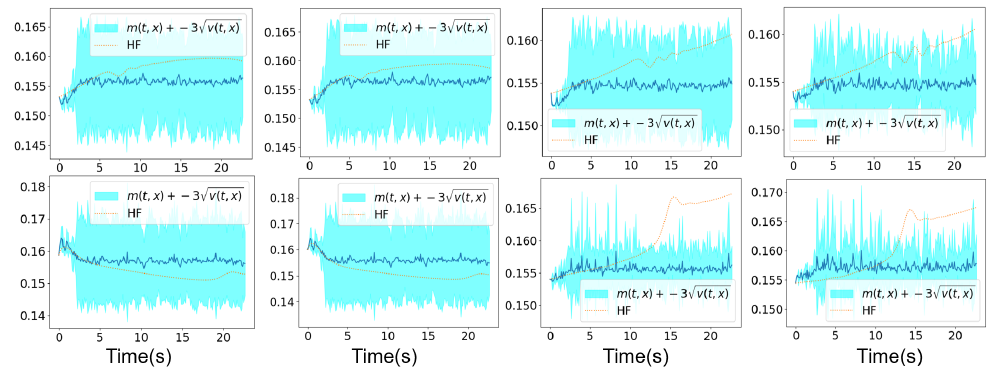
Figure 17. Mesh n°3: High-fidelity Yales2 horizontal velocity projected on the Cartesian mesh in brown and the horizontal component of the mean prediction of the Bayesian ROM in dark blue, at eight different spatial locations. The training data correspond to 15 s simulation time starting from 0 s. An extrapolation is performed from 15 s until 22.64 s. The clear blue zones are the ones contained in three standard deviations around the mean prediction of the ROM denoted m ( t , x ) . The mean prediction is obtained using an aggregation of three samples of the Navier–Stokes solution by the Bayesian nonlinear ROM.